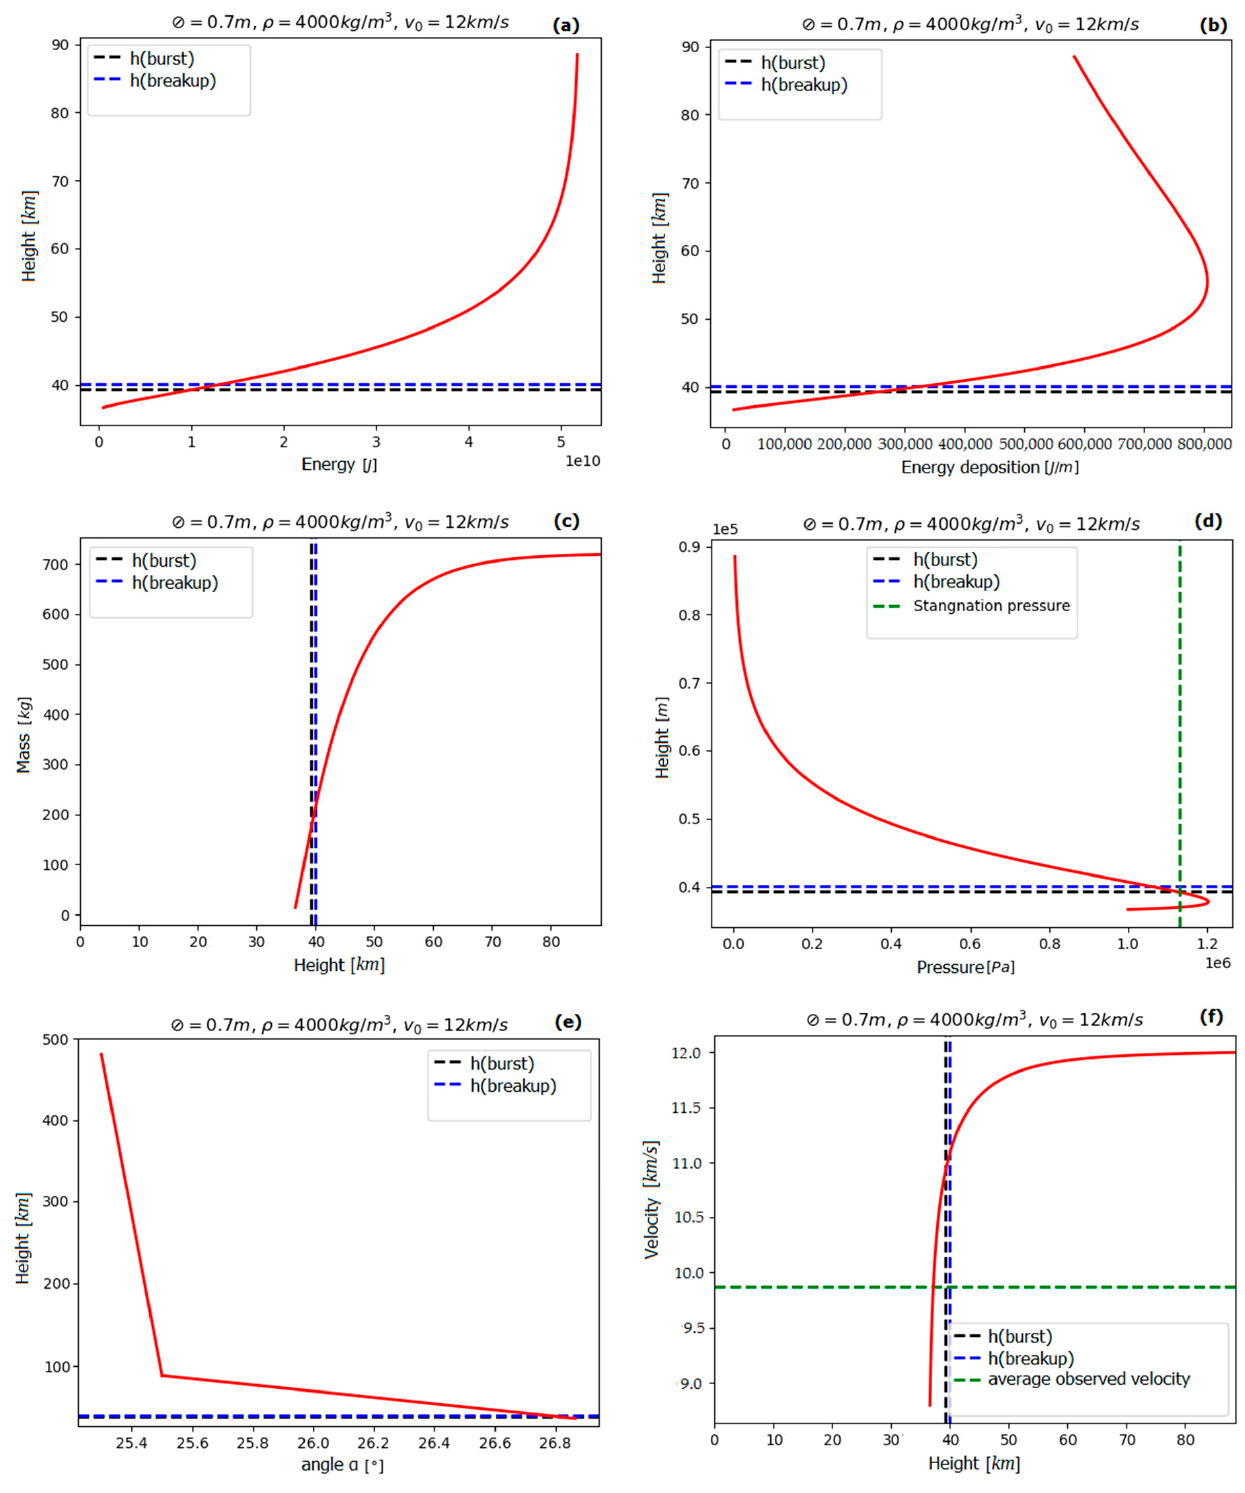
Figure 6. Reconstruction of the Morelian meteoroid passage: ( a ) total energy change with altitude; ( b ) energy deposition, ( c ) mass loss and ( d ) pressure change with altitude; ( e ) α estimation; ( f ) velocity loss with altitude. Blue and black dotted lines indicate modeled break-up and burst heights.